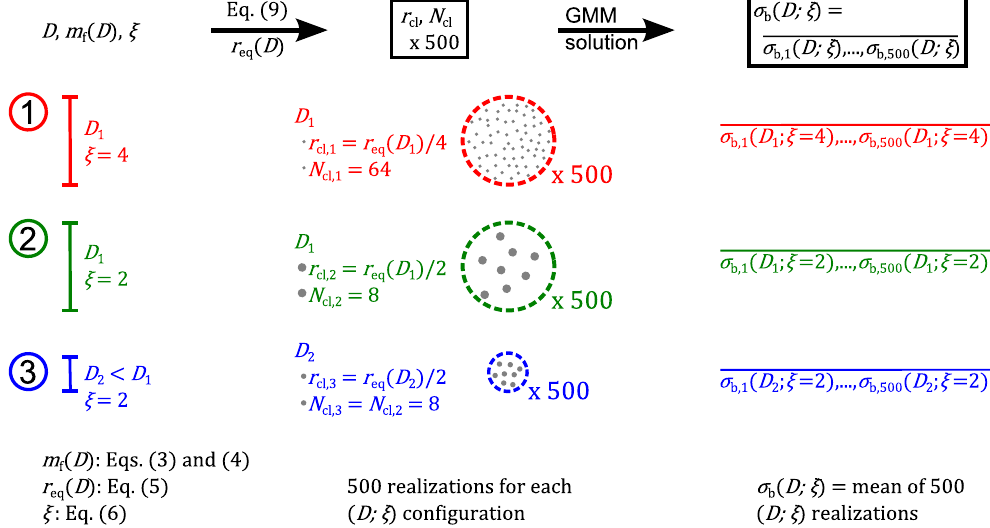
Figure 5. Schematic representation of the modeling approach described in Sect. 3.3, with three examples highlighted in red, green, and blue. The impact of normalized snowflake surface-area-to-volume ratios of 1 ≤ ξ ≤ 5 on modeled snowflake backscatter cross sections σ b is investigated by applying the generalized multiparticle Mie (GMM) solution to collections of randomly distributed ice spheres characterized by the radius r cl and the number N cl of the constituent ice spheres and by the snowflake diameter D indicating the spherical bounding volume of the ice sphere